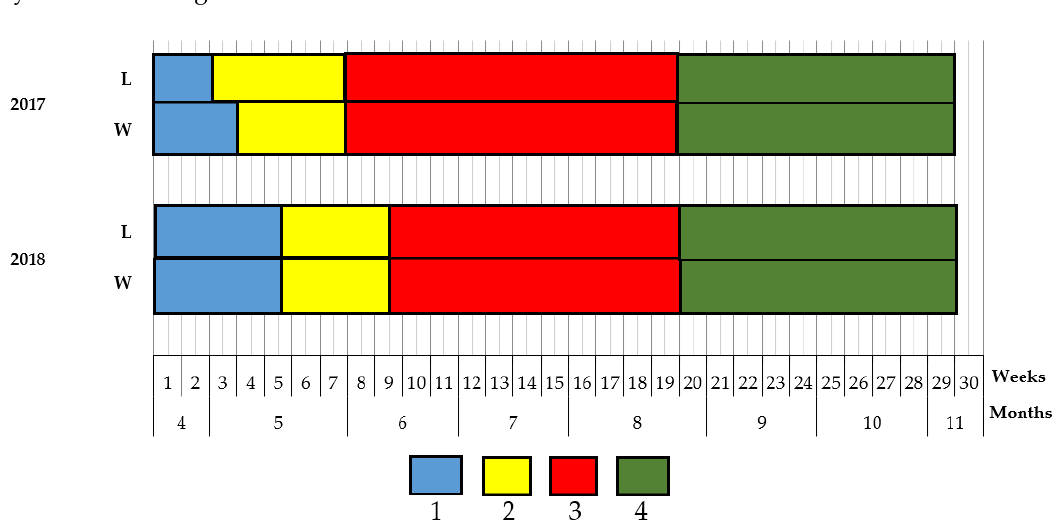
Figure 4. Phenological spectra of each pea on the leeward (L) and windward (W) sides of the foredune: 1—vegetation; 2—flowering; 3—fruiting;